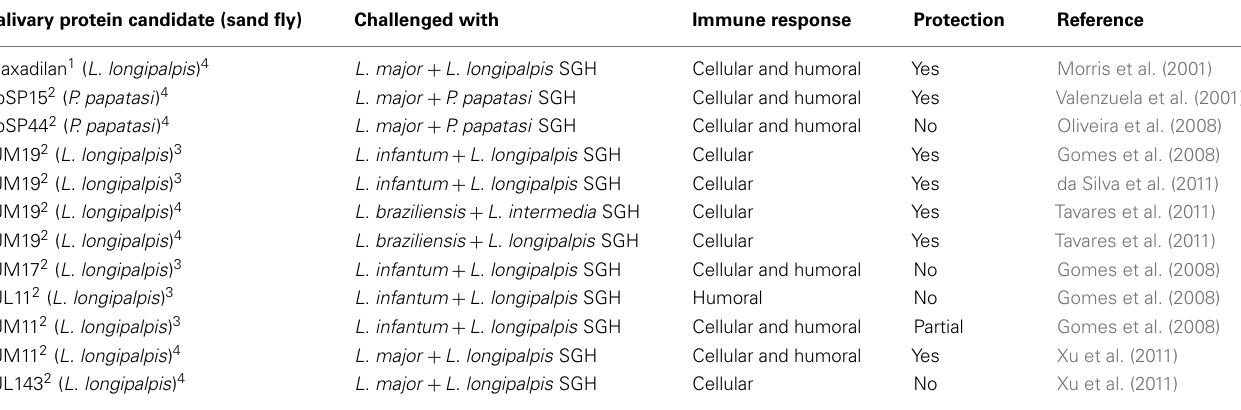
Table 2 | Sand fly salivary proteins tested in animal model of leishmaniasis. Salivary protein candidate (sand fly) Challenged